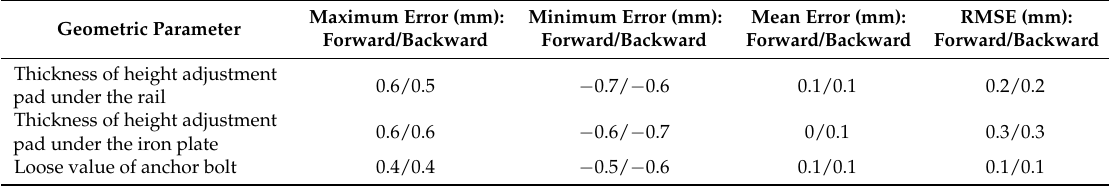
Table 2. Errors in the geometric parameter between manual measurements and the